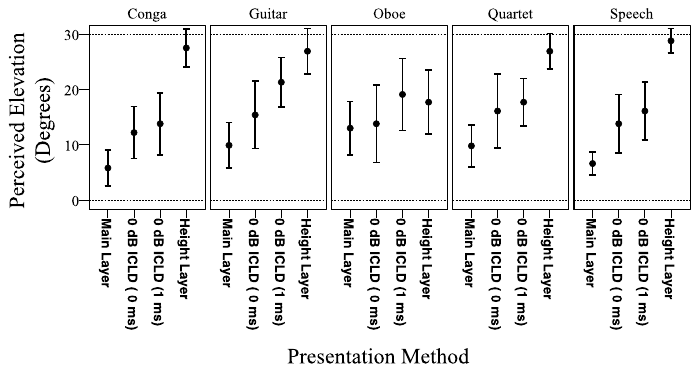
Figure 13. Medians and associated notch edges for the verification test results arranged for the analysis of the localisation dominance effect.